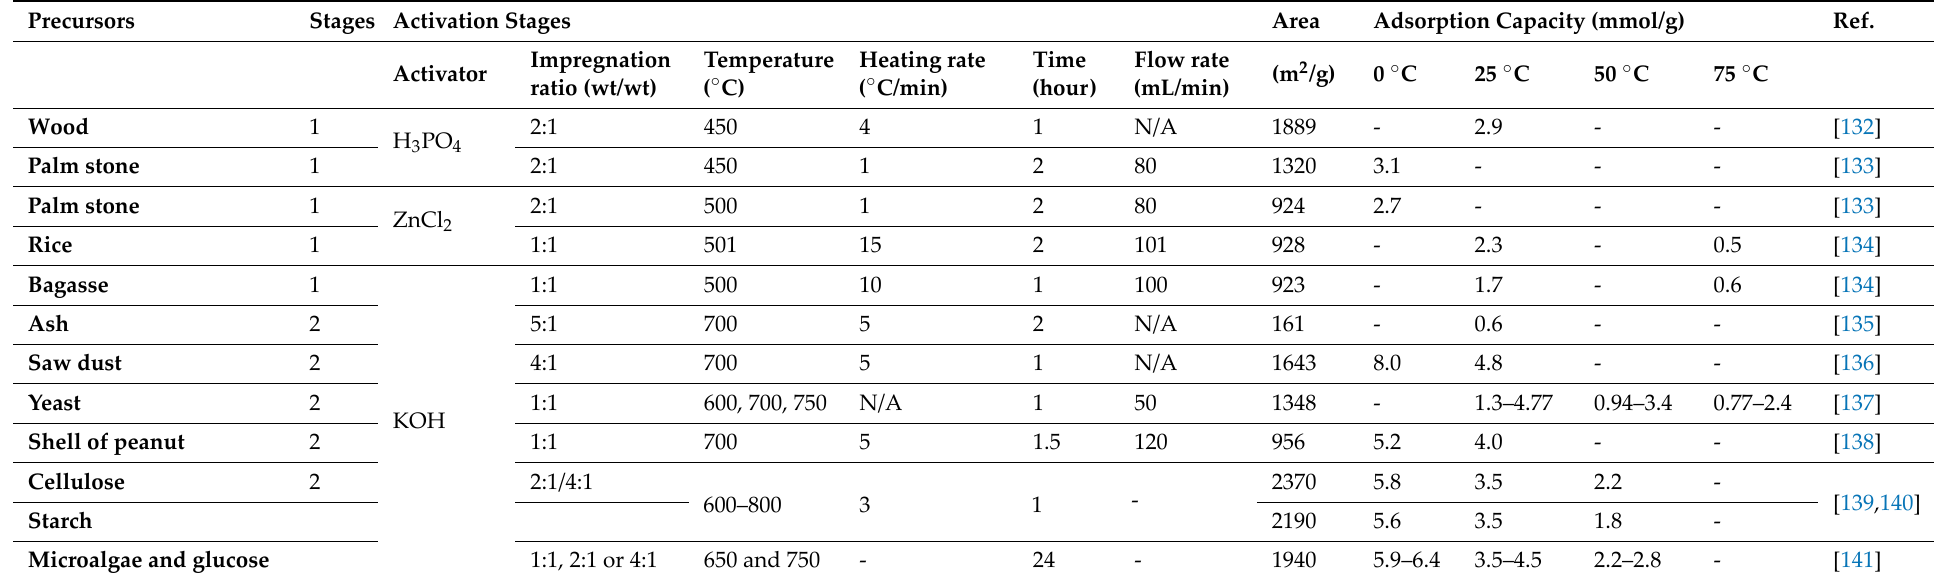
Table 4. Chemical‑activated carbon produced for CO 2 capture under atmospheric